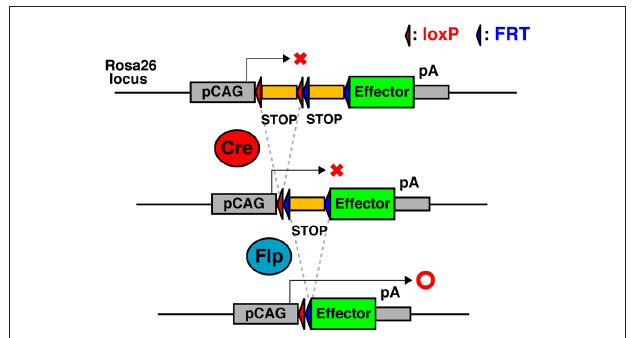
FiguRE 3 | Schematic of Cre- and Flp-dual recombinase responsive allele. The effector-encoding sequence is interrupted by a loxP-flanked STOP cassette followed by a FRT-flanked STOP cassette. The effector protein expresses only when Cre and Flp have been expressed in the same